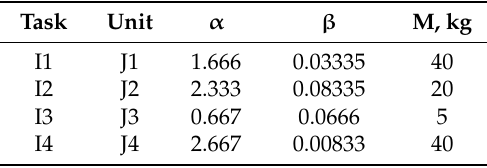
Table 1. Key process parameters for Example 1.